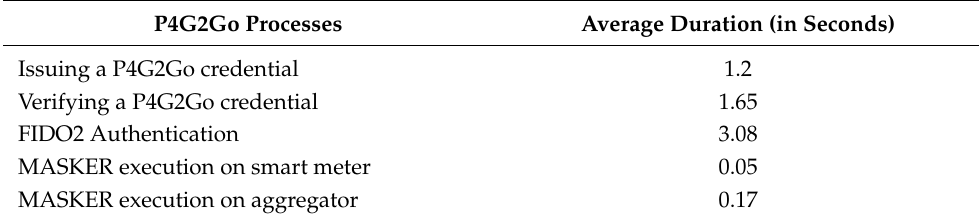
Table 4. Average duration of P4G2Go